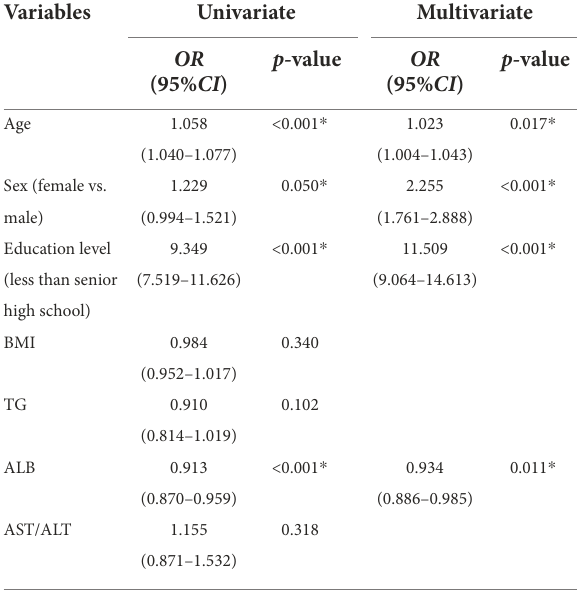
TABLE 3 Multivariate logistic regression analysis for demographics and laboratory parameters of the study population.